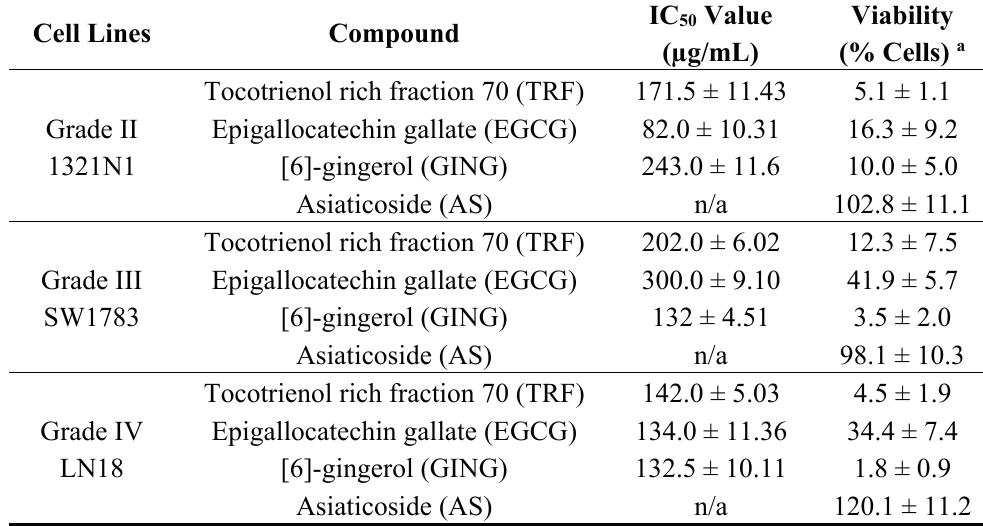
Table 1. (3-(4,5-Dimethylthiazol-2-yl)-5-(3-carboxymethoxy-phenyl)-2-(4-sulfophenyl)- 2H-tetrazolium, inner salt) (MTS) cytotoxic effect of natural bioactives on human glioma cancer cells (1321N1, SW1783, LN18). Viable cells (%) were expressed as the mean ± SD of three independent